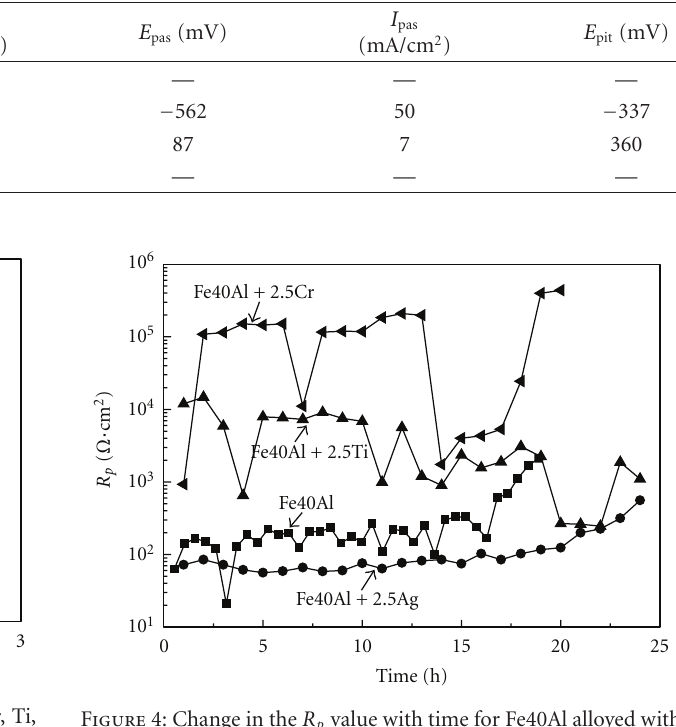
Figure 4: Change in the R p value with time for Fe40Al alloyed with 2.5% Cr, Ti, and Ag in the KCl + ZnCl 2 mixture at 670 ◦